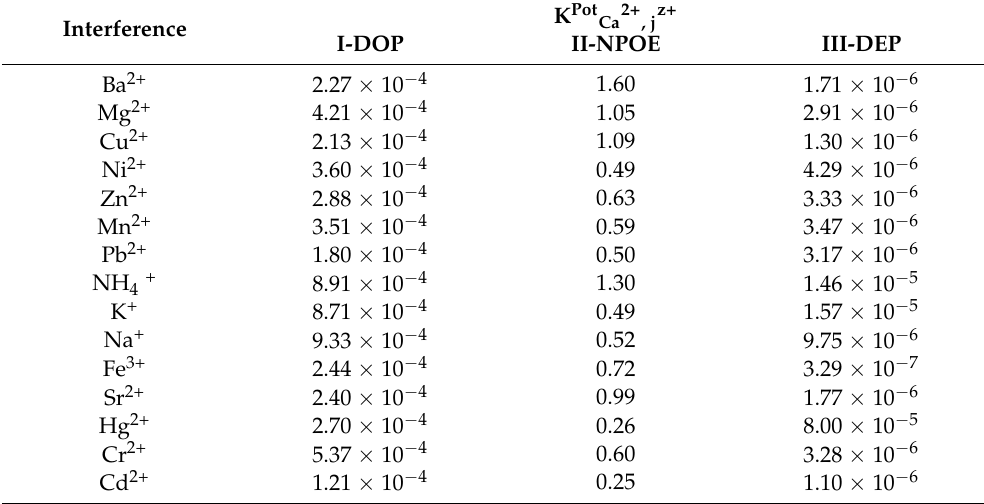
Table 5. Selectivity coefficient values for calcium electrodes based on DNA types I, II, and III.